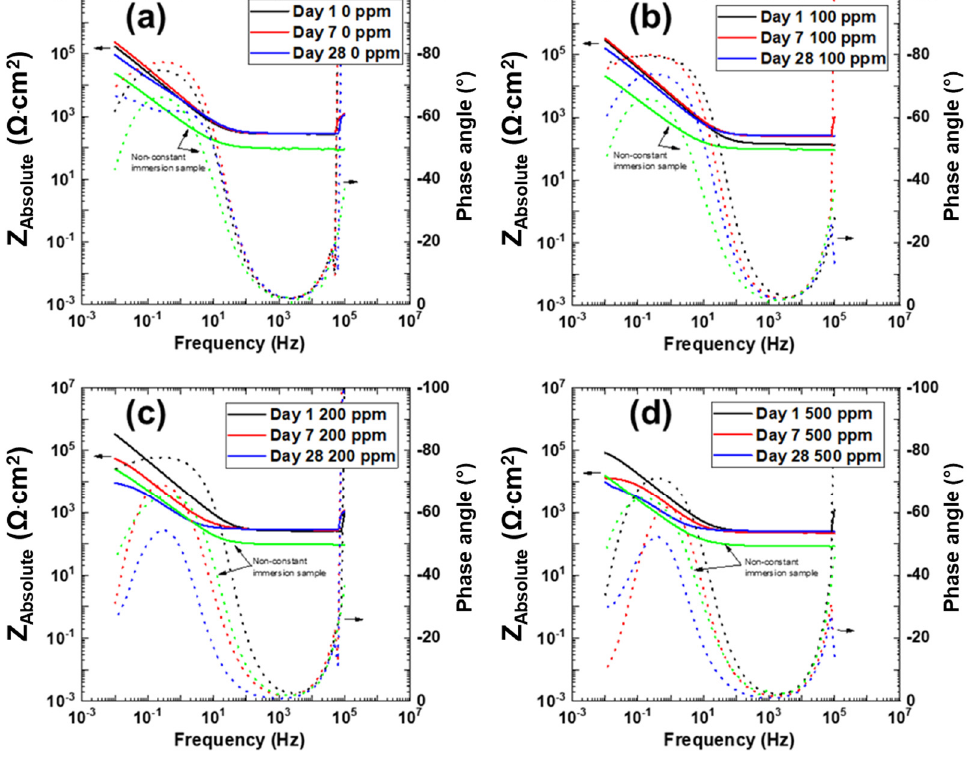
Figure 4. Bode plots of cast iron samples after different constant exposure to engine coolant environment containing ( a ) 0 ppm Cl − , ( b ) 100 ppm Cl − , ( c ) 200 ppm Cl − , and ( d ) 500 ppm Cl − . Solid lines are absolute Z profiles and dotted lines are the respective phase angle profiles of each conditions. Non-constant immersion sample scan was performed after ~30 min of exposure to respective chloride concentration.